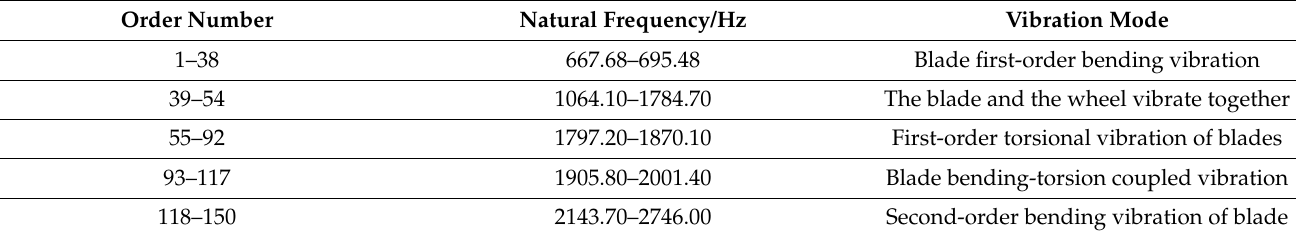
Table 5. The first 150 order natural frequencies and mode shapes of the first-stage bladed disk